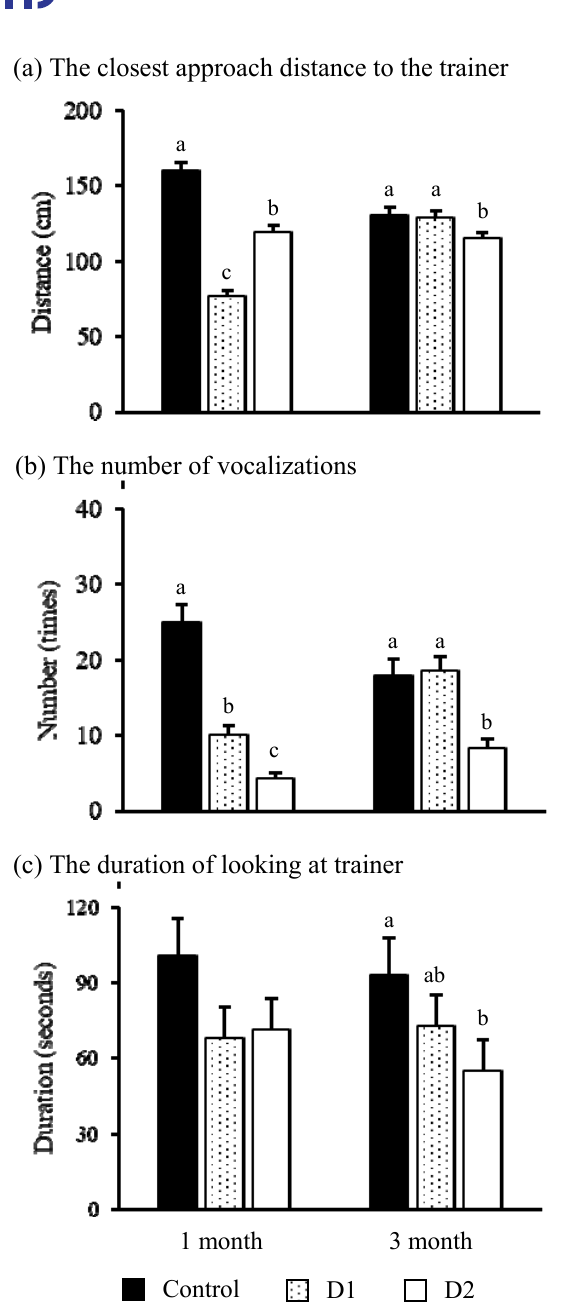
Figure 2. The comparison of (a) the closest approach distance to the trainer, (b) the number of vocalizations, and (c) the duration of looking at the trainer among the control calves (control, closed bar), calves stroked once a day (D1, dotted bar), and calves stroked twice a day (D2, open bar) in each test month in the test for reactions to the stationary trainer. a-c Represents a significant difference among treatments within the month (p<0.05).